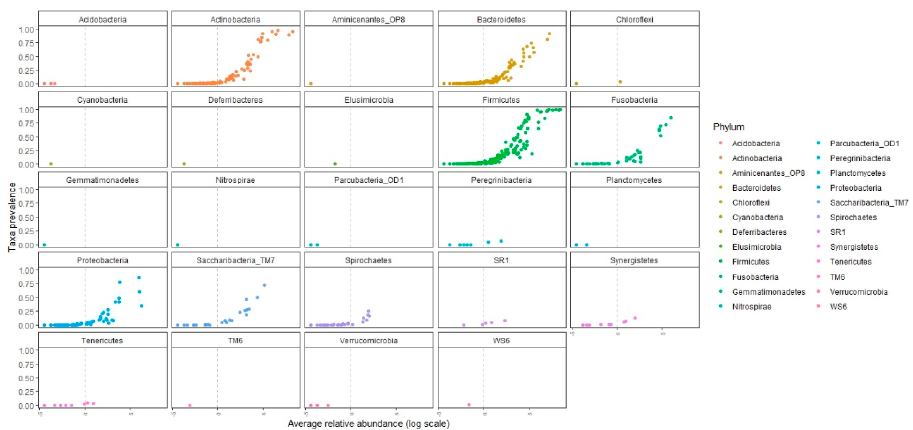
Figure 1. Microbiome structure in saliva: ( A ) phylum level; ( B ) genus level.